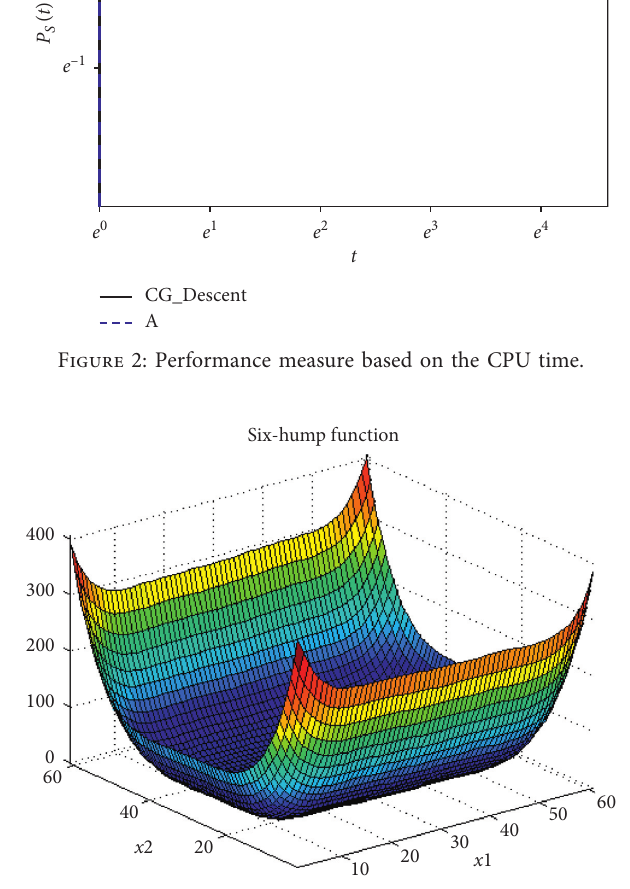
Figure 3: Six-hump camel back function in